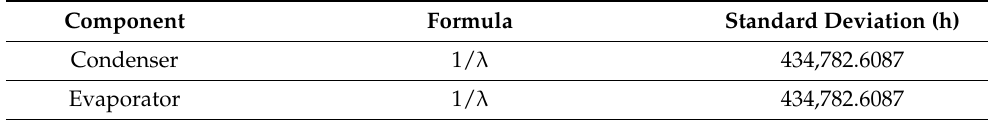
Table 5. List of SDs for each component in the